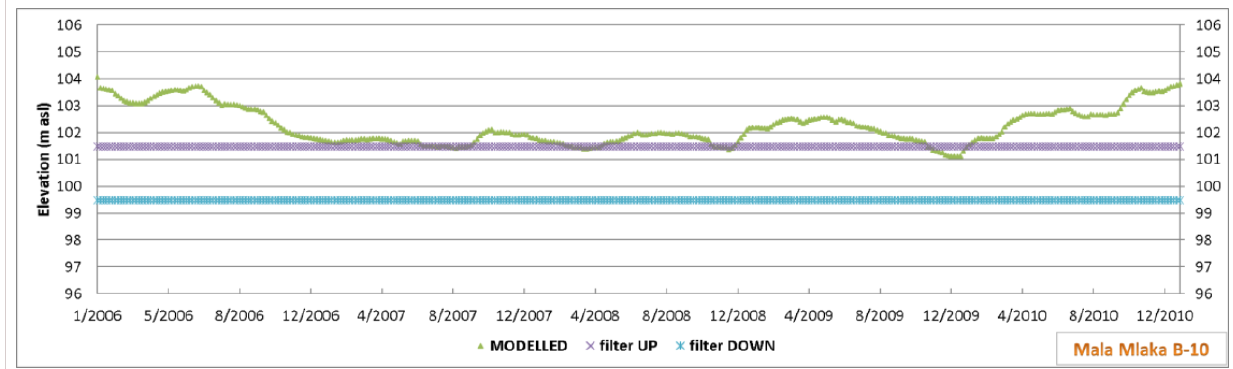
Figure 12. Relationship of modeled groundwater levels with the position of the filter structure of exploitation dug well